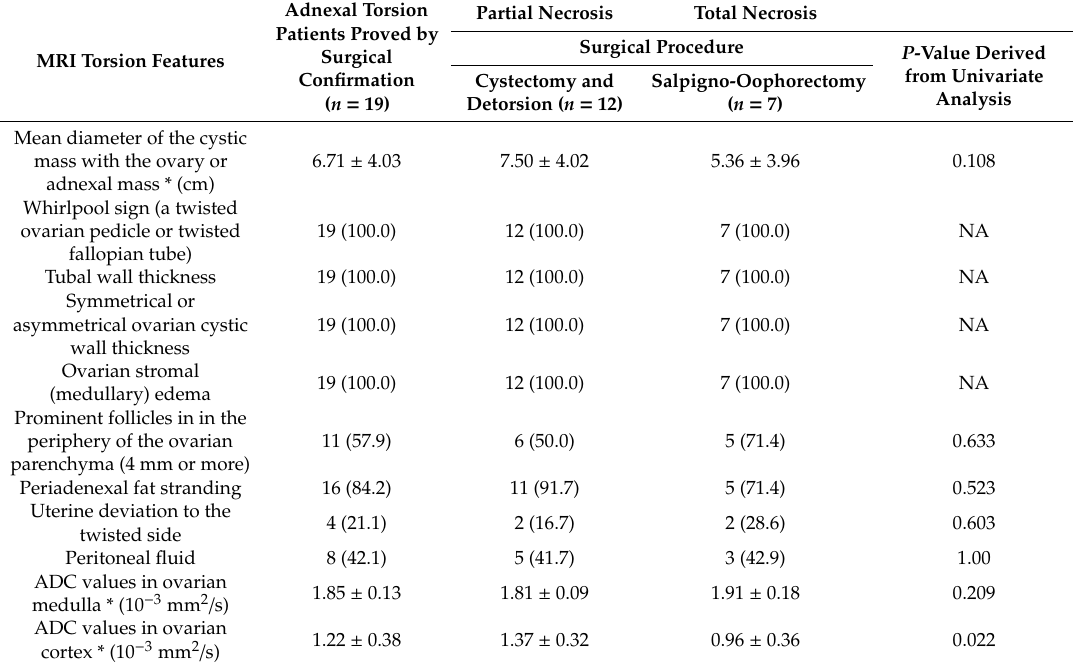
Table 3. MR imaging features for predicting necrosis amid maternal adnexal torsion during